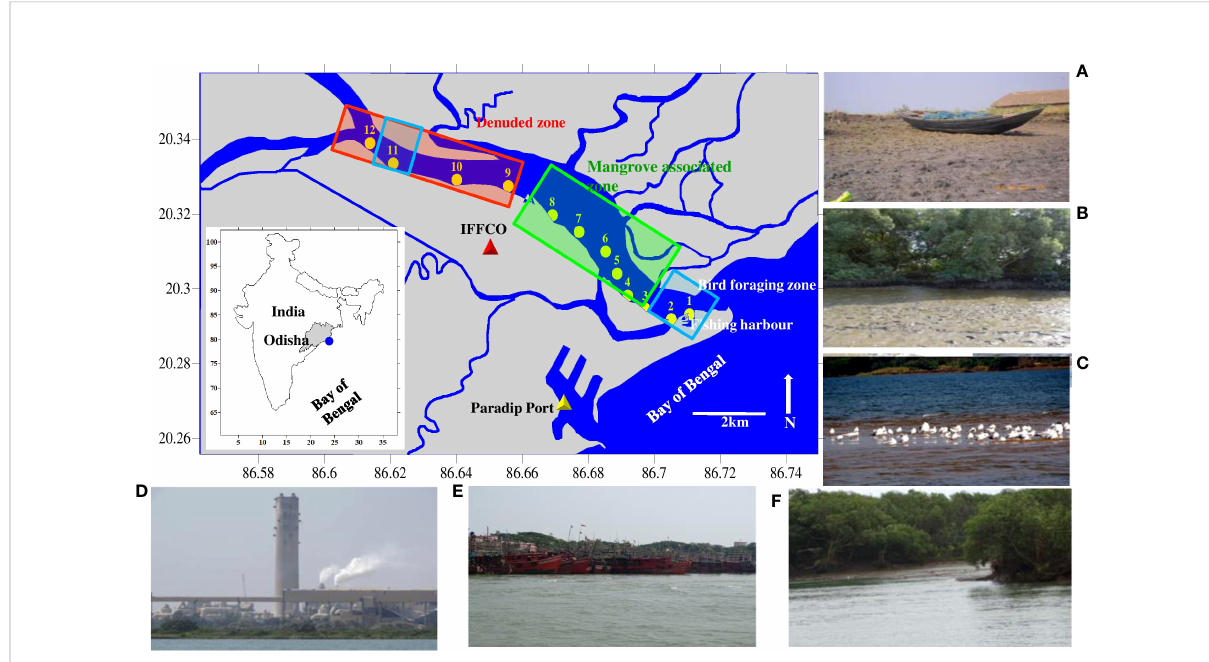
FIGURE 1 Mahanadi estuary in State Odisha on the east coast of India. The sampling stations (1-12) cover the ecotone in fl uenced by the tides, i.e., from the river mouth to 13 km upstream. Examples of each habitat and sources of disturbances are denoted. (A) Denuded zone; (B, C) Mud fl at and bird foraging zone, (D) IFFCO factory; (E) Fishing harbour, and (F) Mangrove associated